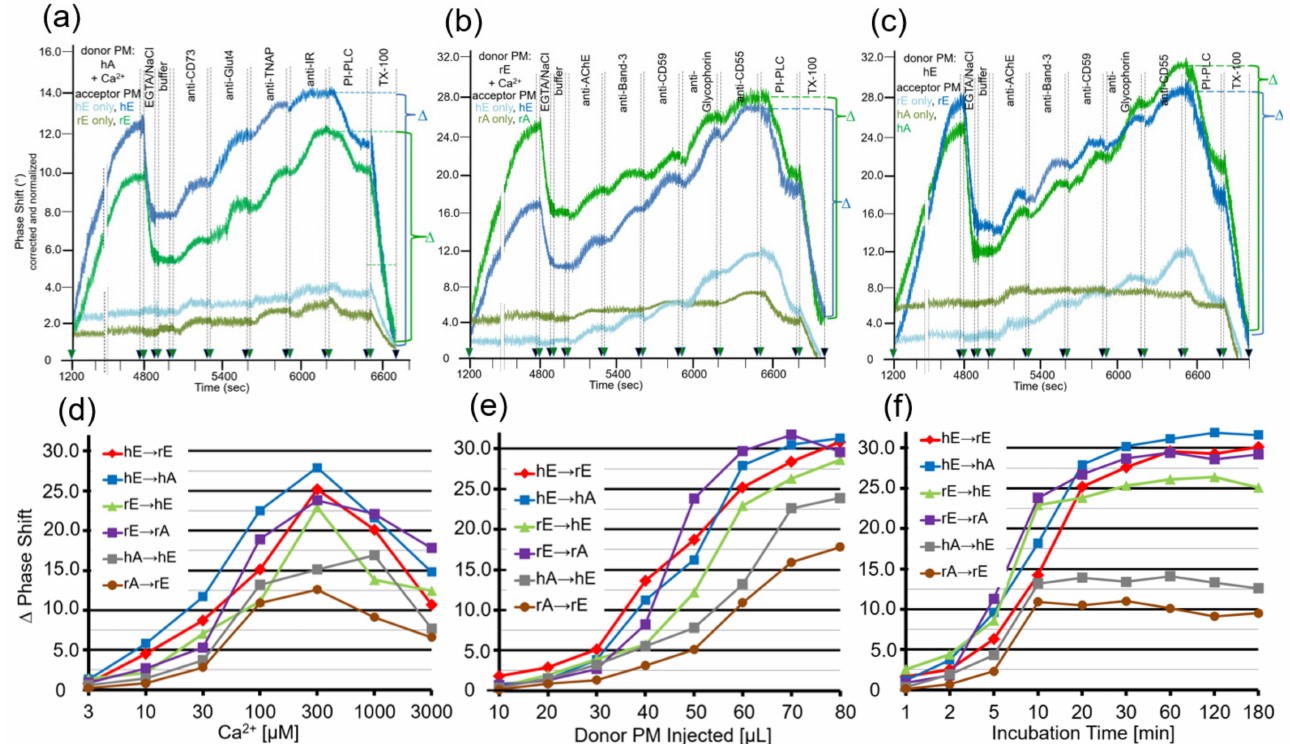
Figure 5. Ca 2+ -dependent fusion of donor and acceptor PM harboring GPI-APs and transmembrane proteins at various combinations ( a – c ) and its dependence on the amount of donor PM ( d ), length of the incubation period ( e ) and concentration of Ca 2+ ( f ). The experiment was performed as described for Figure 3 with injection at 800–1200 s of 85 µ L ( a – d , f ) or increasing volumes ( e ) of donor PM at a flow rate of 13 µ L/min and subsequent incubation (37 ◦ C) of the donor–acceptor PM combinations or acceptor PM only as indicated (in the absence of PI-PLC and α -toxin) in the presence of 100 µ M Ca 2+ ( a – c , e , f ) or increasing concentrations ( d ) for 60 min (1200–4800 s, ( a – e )) or increasing periods of time ( f ). ∆ phase shifts as measure for GPI-AP transfer are calculated as described for Figure 3. The experiments were repeated two times with similar results. Mean values are given for each donor–acceptor PM combination ( d – f